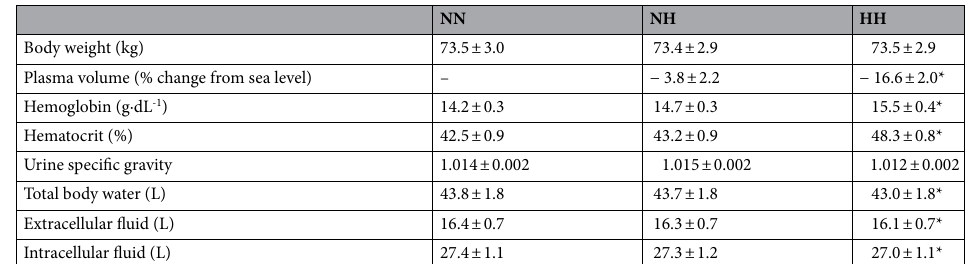
Table 2. Body weight, hemoglobin, hematocrit, plasma volume, urine specific gravity, and body water following acute exposure to normobaric normoxia (NN), normobaric hypoxia (NH), and hypobaric hypoxia (HH). * p < 0.05 from NH and NN. Data presented as means ±